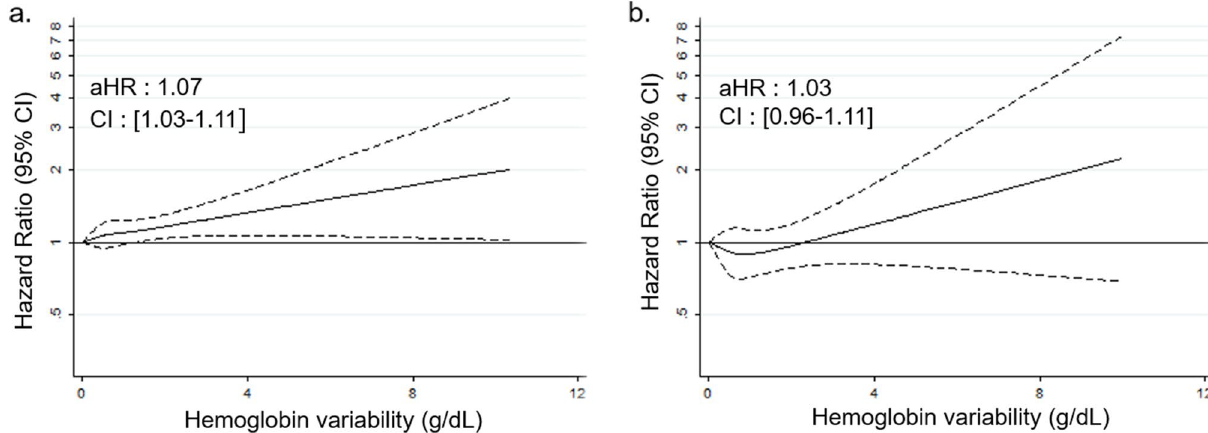
Figure 3. Restricted cubic spline graph of hazard ratio for cardiovascular disease in the subgroups of ESC SCORE : Low-to-moderate risk group ( a ) and High risk group ( b ). Hazard ratio is calculated by Cox proportional hazards regression analysis after adjustments for age, sex, initial hemoglobin level, change in hemoglobin level, household income, smoking, alcohol consumption, physical activity, systolic blood pressure, fasting serum glucose, total cholesterol, and Charlson comorbidity index. P value for interaction between the subgroups is 0. 434. ESC SCORE European Society of Cardiology Systemic Coronary Risk Estimation, aHR adjusted hazard ratio, CI confidence